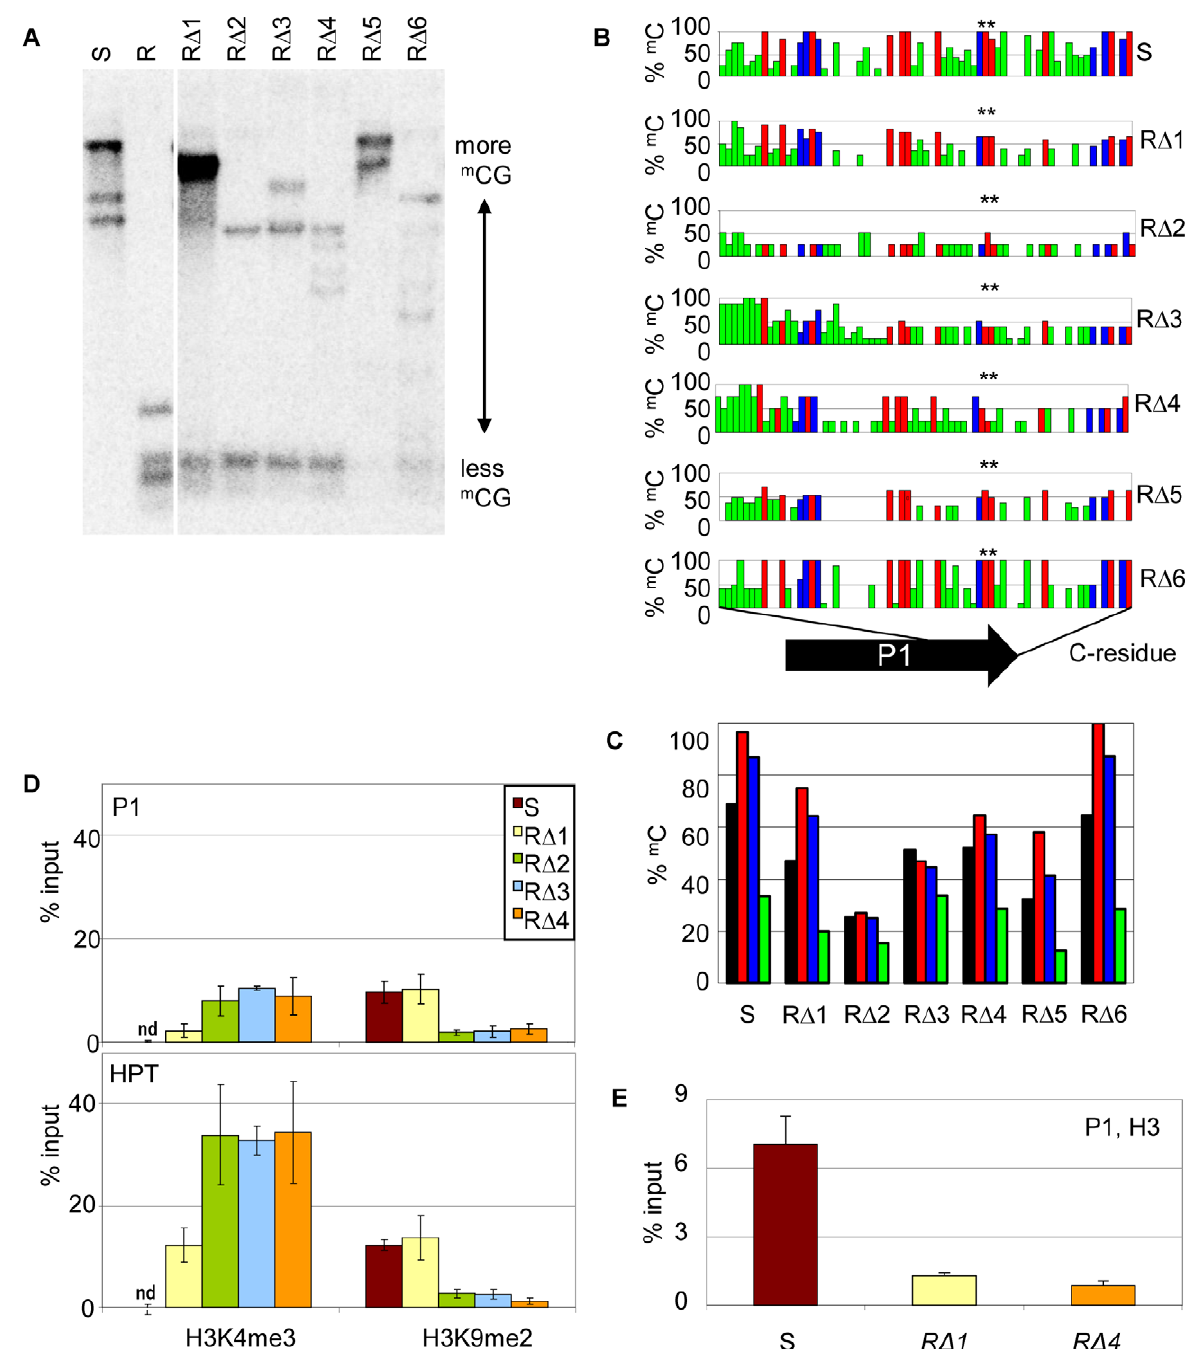
Figure 4. Sequence rearrangements change chromatin features. (A) Methylation analysis in three week-old seedlings of the cis -mutants. Genomic DNA was treated with Hpa II not cutting m C m CGG, blotted and hybridized to a probe spanning the P1 promoter and the HPT gene. (B,C) DNA methylation in sequence-specific context (black: total m C, red: m CG, blue: m CHG, green: m CHH) at promoter P1 in the cis- mutants analyzed by bisulfite sequencing. Methylation at individual sites (B), summary of methylation across P1 (C). (D,E) Analysis of histone H3 at promoter P1 (amplicon 133 bp) and the HPT gene (amplicon 137 bp; primers see Table S4) in selected cis- mutants by chromatin immunoprecipitation. (D) Association with H3K4me3 and H3K9me2; nd: not detectable; (E) modification-independent precipitation. Inactive (S) and active (R) epiallele, resistant cis- mutants derived from line S (R D 1-6).